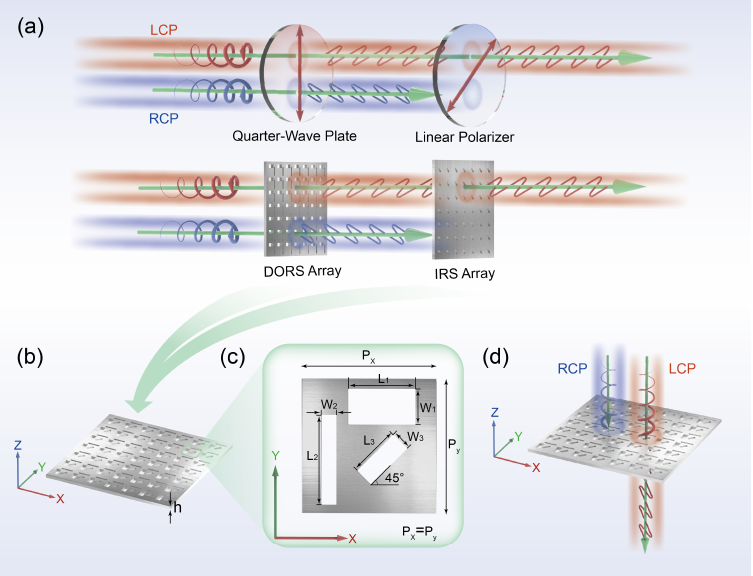
Figure 1. ( a ) Schematic diagram of the single-layer transmissive chiral plasma metasurface (SCPMs). Summarily, the array of double orthogonal rectangular slots (DORS) and the array of spatial π/4 inclined arrangement of the rectangular slot (IRS) are approximately equivalent to a quarter-wave plate and a linear polarizer, respectively. ( b ) Profile of the SCPMs. The aluminum film is etched with an array of periodic structures whose basic unit is composed of DORS and IRS. The thickness h of the aluminum film is 200 nm. ( c ) Unit cell with the associated geometric features. L 1 , W 1 , L 2 , W 2 , L 3 and W 3 are set to 258, 136, 338, 56, 198 and 76 nm, respectively. The distance from the center of the spatial π/4 inclined arrangement of the rectangular slot to the center of the double orthogonal rectangular slot is 200 nm. The periods of unit cell are P x = P y = 400 nm in the x and y directions. (We focus on the left-handed structure; if the angle of the tilted rectangular slot becomes −π/4, it will be transformed into a right-handed structure.) ( d ) Illustration of the optical response at the designed wavelength of 532 nm.